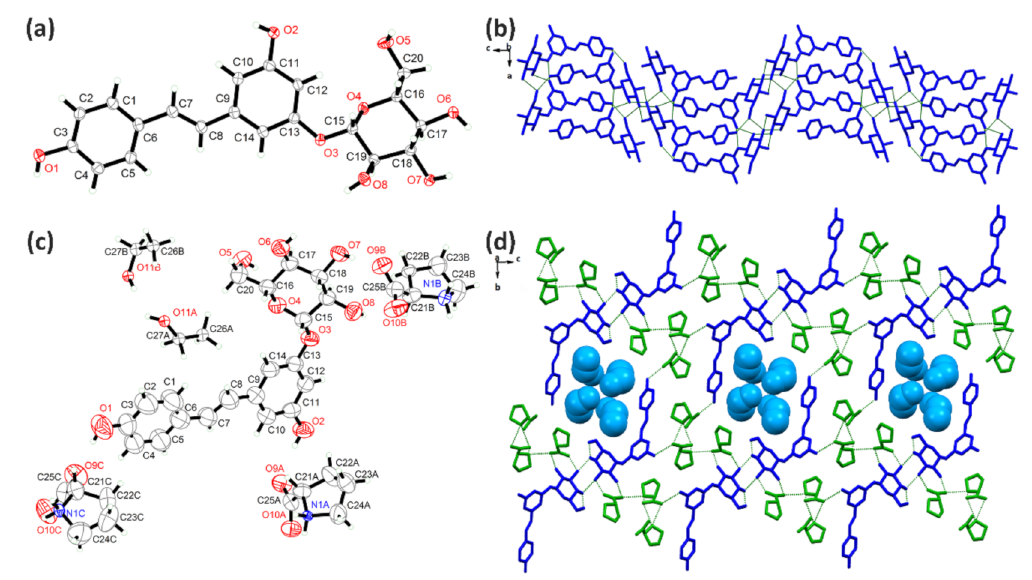
Figure 6. The asymmetric unit of PD ( a ) and PD-L-Pro ( c ), as well as their hydrogen-bonded network ( b , d ).